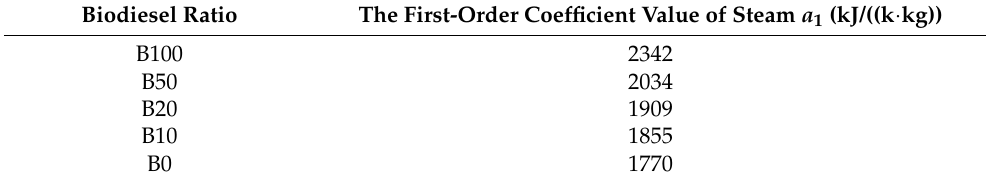
Table 2. Evaporation coefficient ( a 1 ) of different ratios biodiesel.